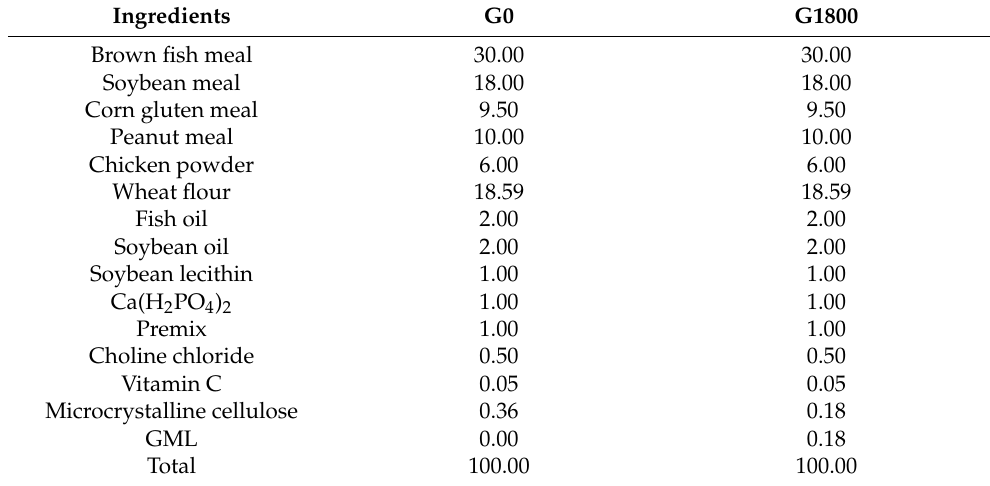
Table 1. Ingredients and chemical compositions of experimental diets (% DM